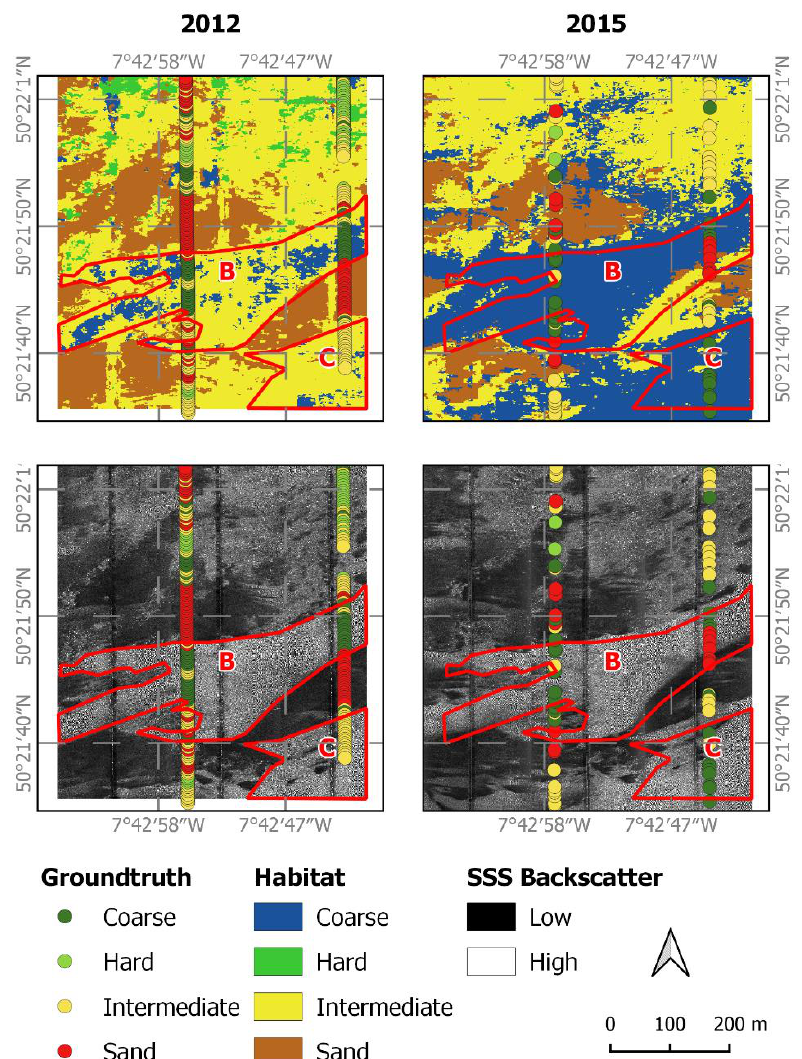
Figure 14. Example of classification changes between 2012 and 2015 at the southern end of the study site, note variation in delimited regions identified as ‘B’ and ‘C’. Groundtruthing confirmed that a large part of the intermediate habitat had been transformed into coarse substratum (area ‘C’), a potential indication of sediment mobility in the area. Mercator projection with standard parallel 50. WGS84 datum.